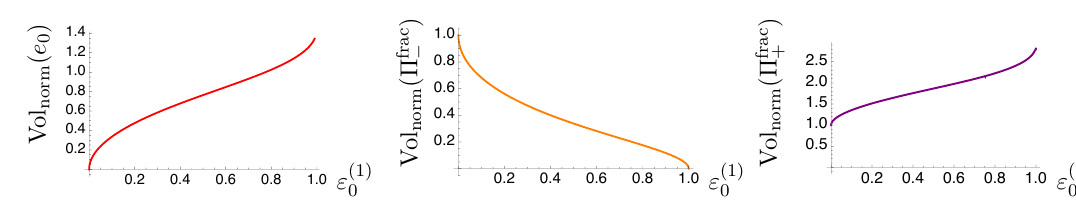
on T 4 = Z 6 (left) and the fractional cycles 0 (1)